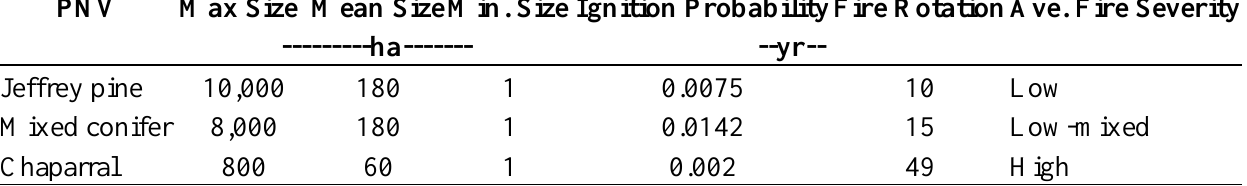
Table 1. Historical fire regimes as parameterized to approximate historic fire rotation and severities reported in the literature [24,75,76].